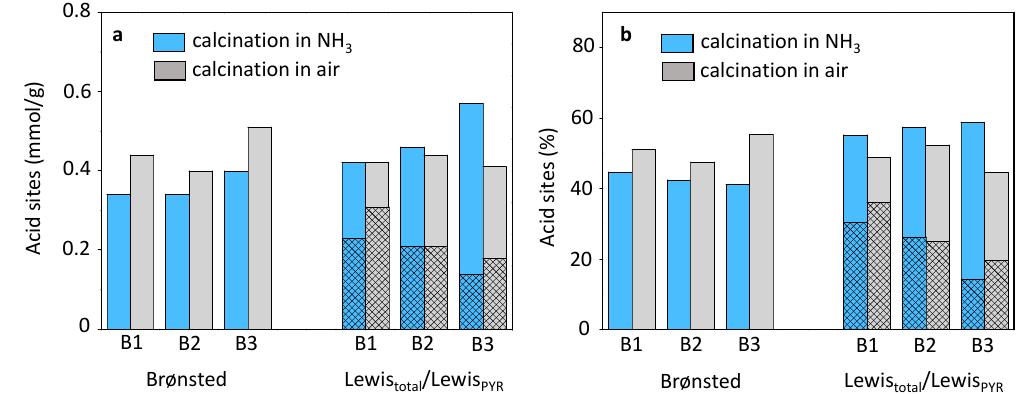
Figure 9. Comparison of the Brønsted and Lewis acid sites concentration (Lewis total derived from FTIR of acetonitrile adsorption; Brønsted and chequered Lewis PYR derived from pyridine adsorption) in mmol / g ( a ) and as percentage value ( b ) in B1–B2 beta zeolites.